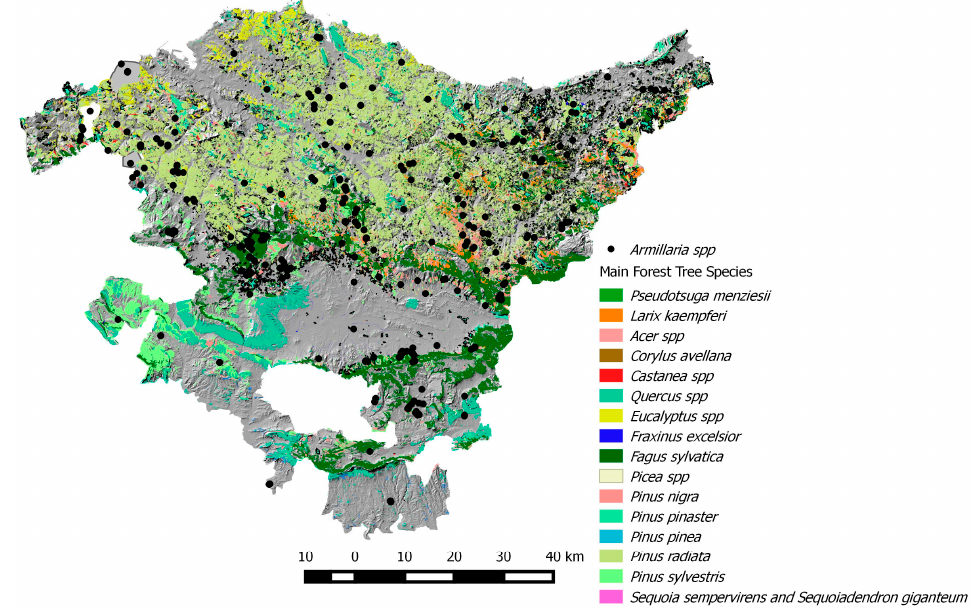
Figure 2. Distribution of Armillaria spp. and main forest tree species of the Basque Country.